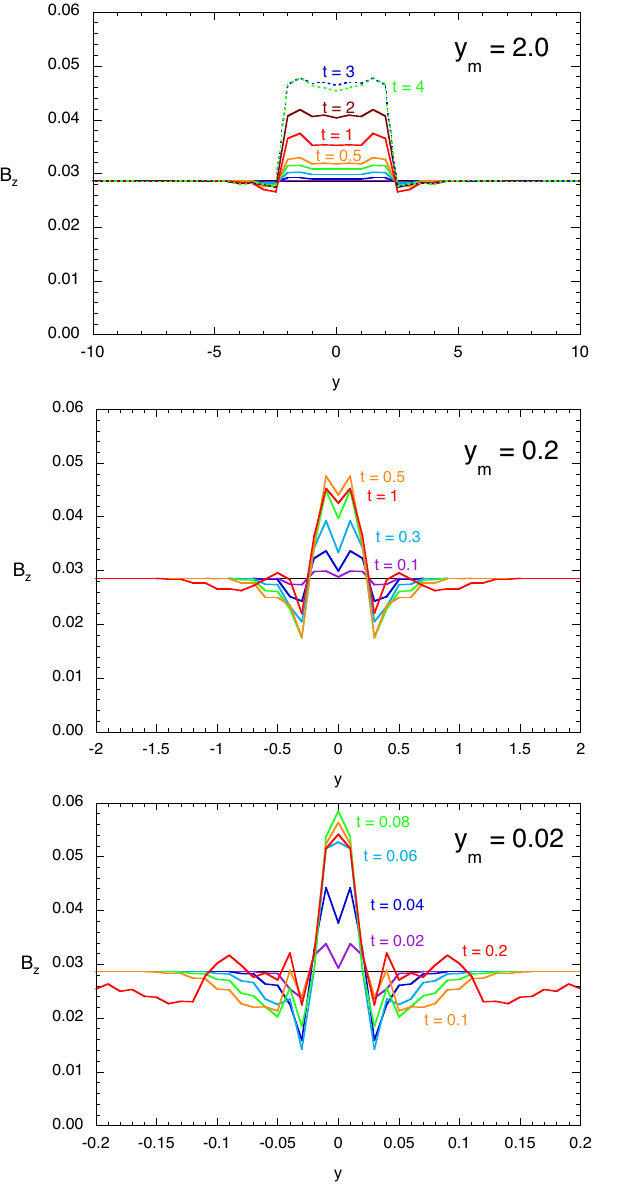
Fig. 2. Magnetic field B z at x =− 7 . 4 ,z = 0 as a function of y at different times and for 3 different bubble widths, as indicated.